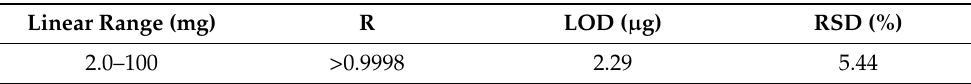
Table 3. S content analytical performance of the instrument.